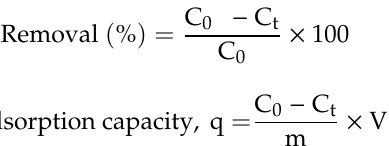
Figure S1: XRD pattern for PAN / SL (a) carbonized, (b) stabilized and (c) nanofibers, and PAN (d) carbonized, (e) stabilized and (f)